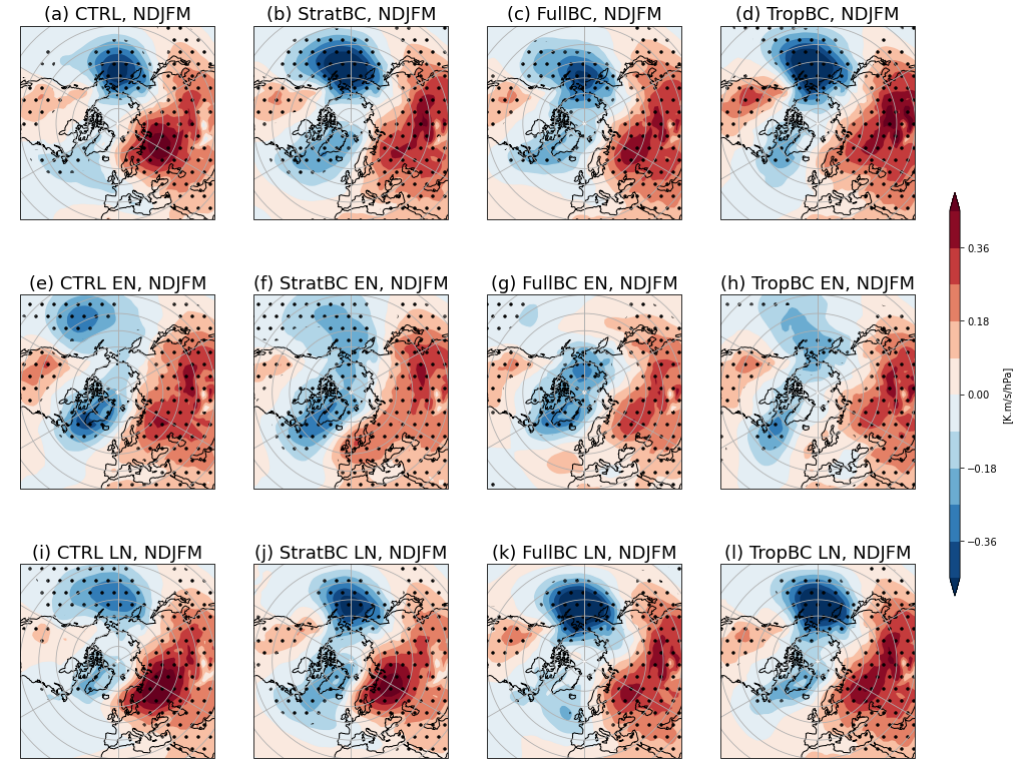
Figure 5. Regression of monthly HF and monthly sea level pressure for extended winter months (November–March). The top row is neutral years, the middle row is El Niño years, and the bottom row is La Niña years. Stippling indicates significance at p< 0 .